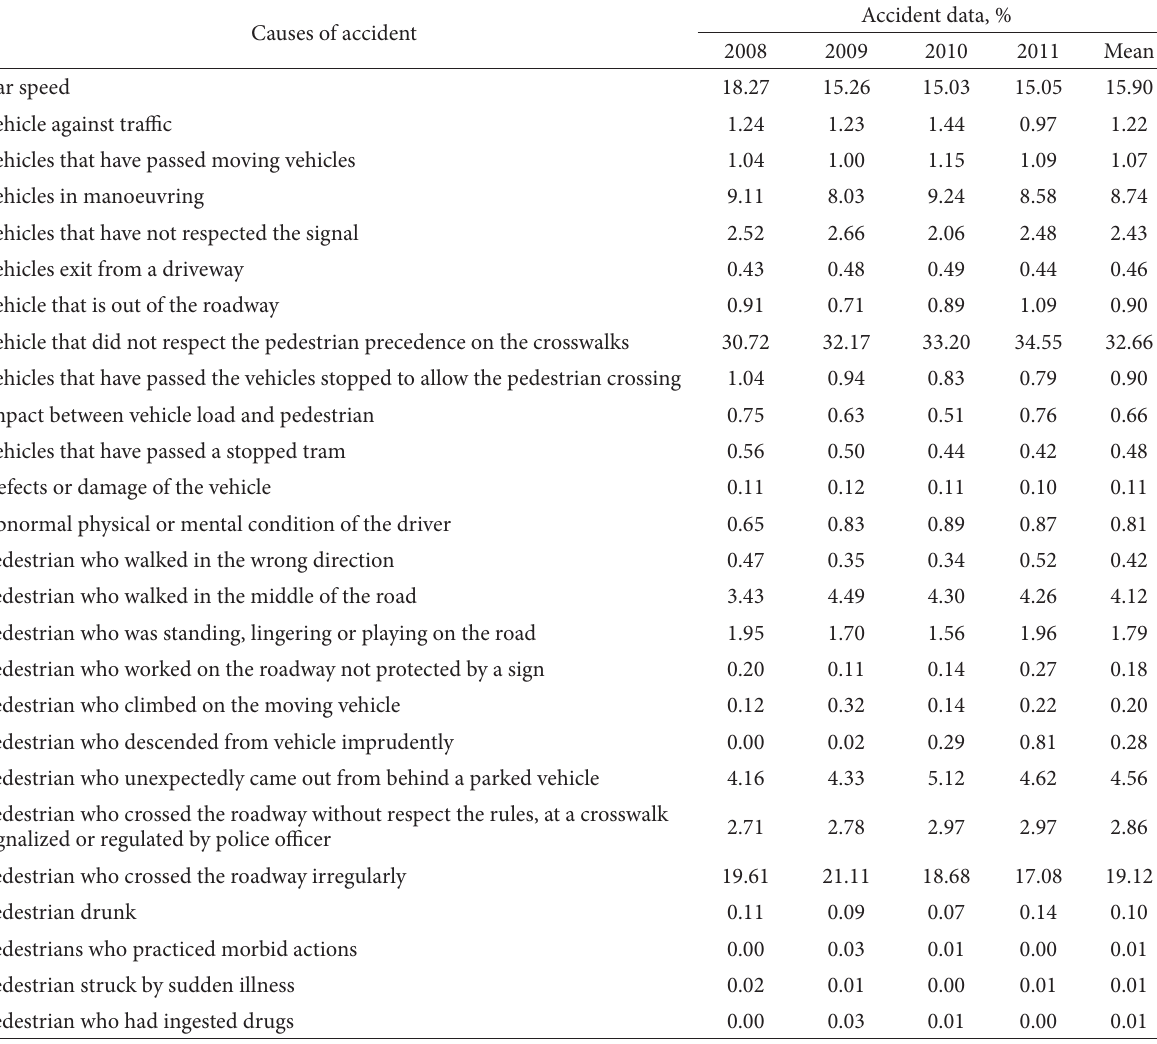
Table 3. ISTAT data on pedestrian accidents (2008−2011 years) Causes of